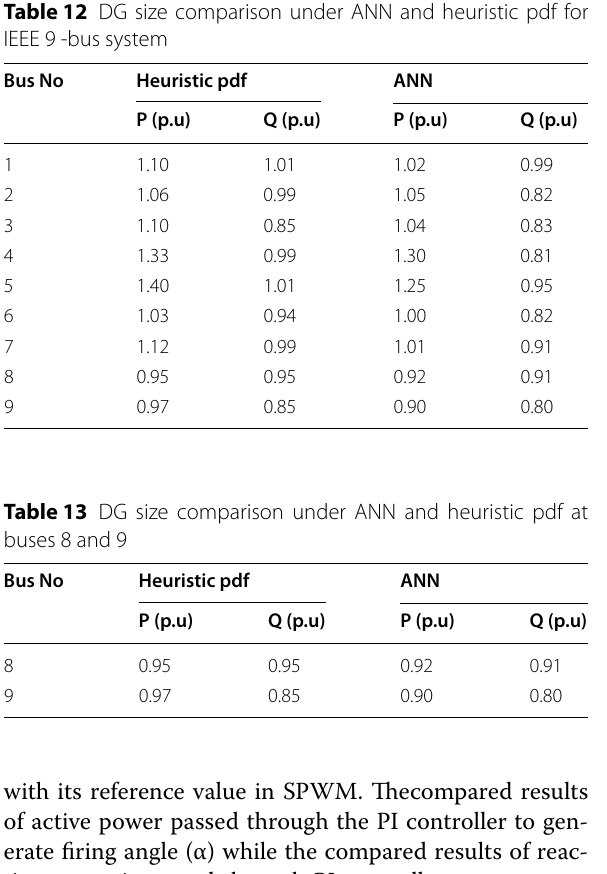
Table 12 DG size comparison under ANN and heuristic pdf for